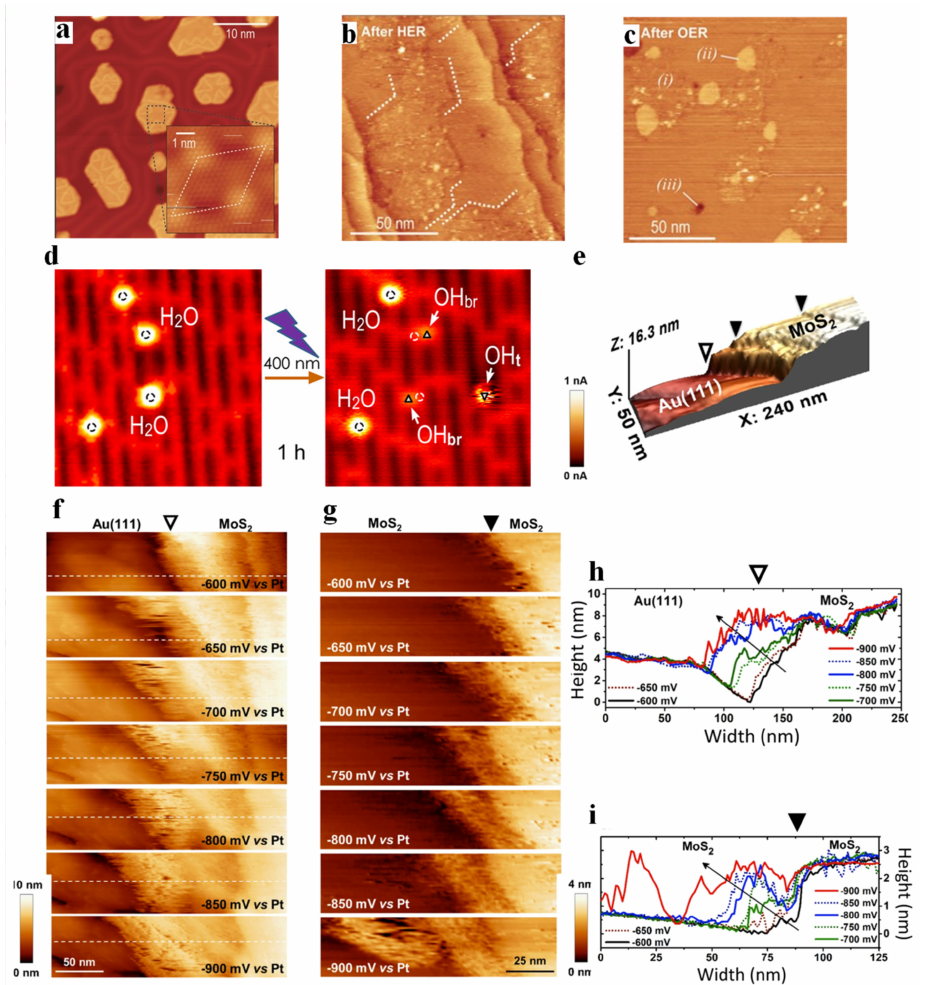
Figure 1. STM images of Co − O bilayer nanoislands on Au (111) in STM ( a ), the cobalt oxide/Au (111) surface after HER ( b ). The Co − O/Au (111) surface after OER ( c ). Italic numbers indicate cobalt oxide ( i ), gold islands ( ii ) and single atom deep pits in the Au (111) surface ( iii ). Adapted with permission from ref. [43]. Copyright 2018 John Wiley & Sons, Inc. STM images (6.3 × 6.6 nm 2 , imaged at 1.0 V and 10 pA, 80 K) ( d ) showing the dissociation of water molecules under 400 nm UV irradiation for 1 h. Adapted with permission from ref. [47]. Copyright 2012 American Chemical Society. A boundary images visualizing a MoS 2 /Au (111) boundary and a step edge at the surface of the MoS 2 film under HER conditions with increasing overpotentials. A set of images characterizing the ( f ) MoS 2 /Au (111) boundary (open triangle) and ( g ) a step edge at the surface of the MoS 2 film (filled triangle) at different electrode potentials as indicated in the figure. Line profiles across ( h ), ( i ) the same position for each potential from ( f , g ), respectively. Adapted with permission from ref. [50]. Copyright 2019 Springer